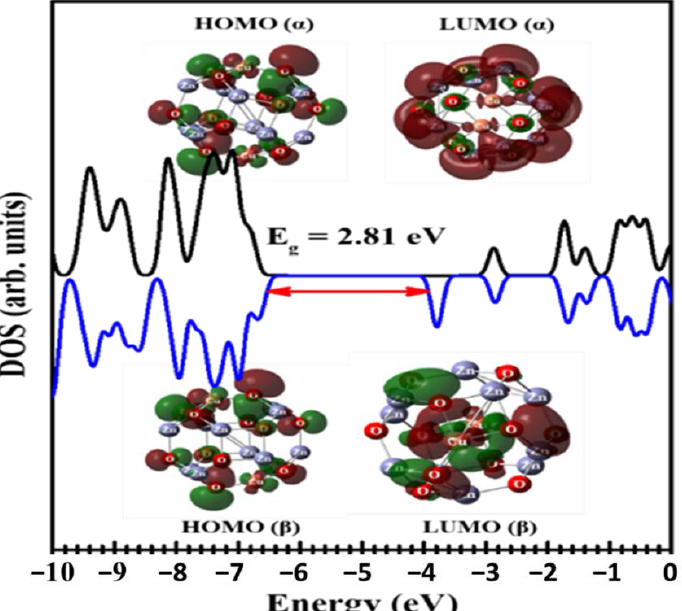
Figure 3. DOS for the Cu 2 Zn 10 O 12 substrate cluster. HOMO and LUMO are inserted.